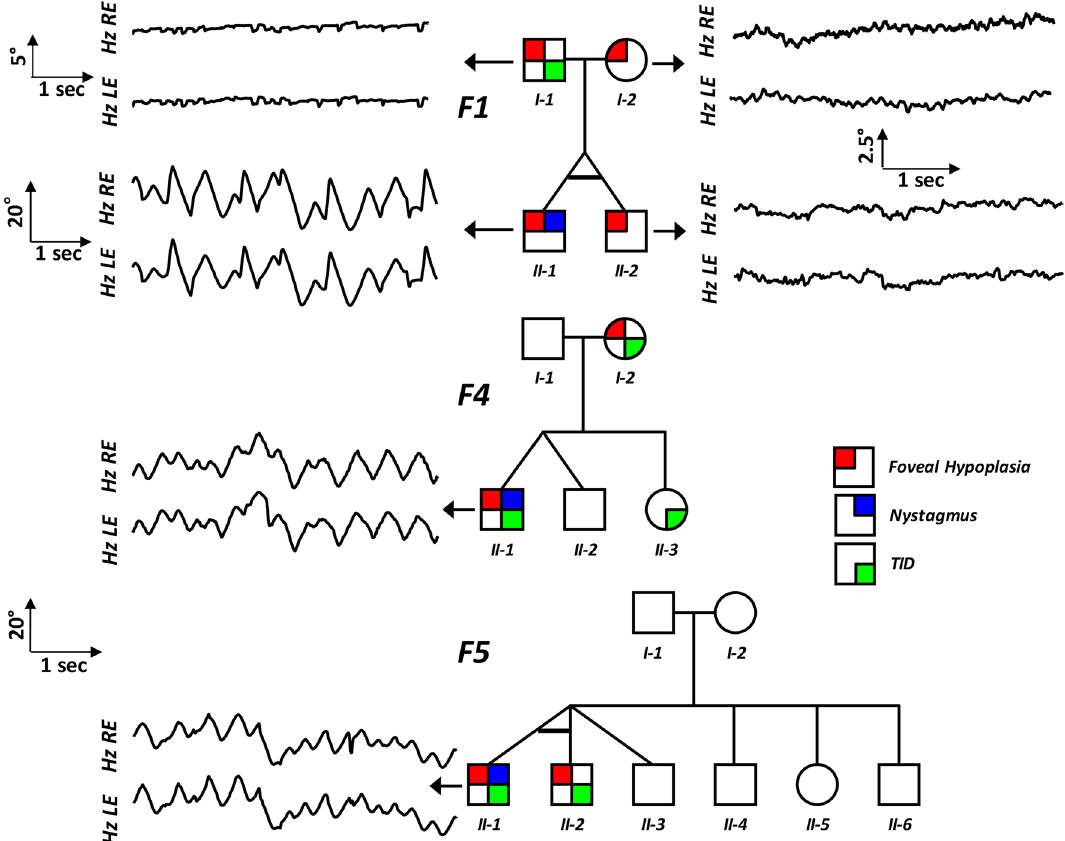
Figure 2. Eye movement recordings. Original eye movement recordings (EMR) in nystagmus families with monozygotic twins (F1), dizygotic twins (F2) and triplets (F5). In family F1, the proband (II-1) had high intensity nystagmus with pseudocycloid/pseudojerk waveforms. The father (I-1) had square-wave jerks and subclinical nystagmus identified on EMR. Similarly, other family members (I-2 and II-2) had subclinical nystagmus. In family F4, only the proband (II-1) had nystagmus with a pseudopendular with foveating saccades waveform. In family F5, only the proband (II-1) had